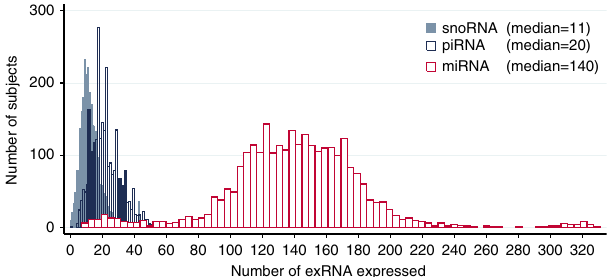
Figure 3 | Distribution of plasma exRNA expression in 2,763 Framingham Heart Study participants. From the RNAseq data we developed a list of observed exRNAs to target using high-throughput RT-qPCR (Fluidigm BioMark system). The expression of 331 human miRNAs, 97 human piRNAs, and 43 human snoRNAs were measured (Cq o 23). Because piRNAs have a 3 0 modification (2 0 - O -methylation), we utilized a modified RT-qPCR approach. The abundance and distribution of each type of small-RNA in the FHS cohort is illustrated in Figure 3 and shows that 50% of the FHS cohort expressed at least 11 snoRNAs and 20 piRNAs in plasma. These results demonstrate considerable variability in terms of number of exRNAs detected in plasma in each participant as well as the overall percent